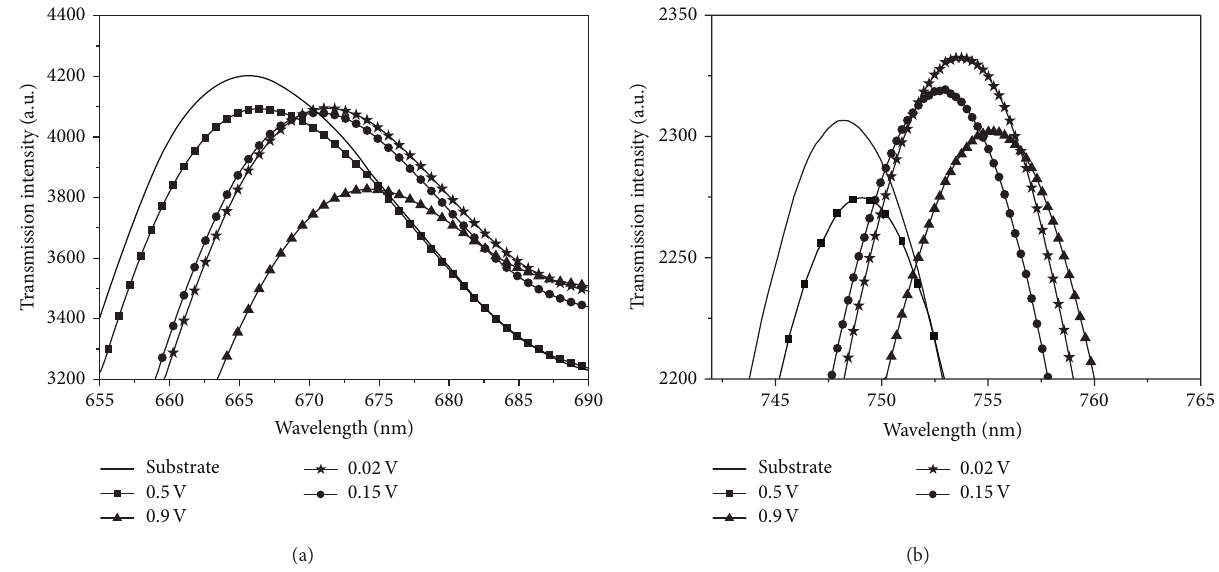
Figure 2: T-SPR spectra (wavelength scan) during electropolymerization of 3-ABA in 0.5 MH 2 SO 4 at various potentials for 1 cycle on (a) BD-R and (b) DVD-R grating